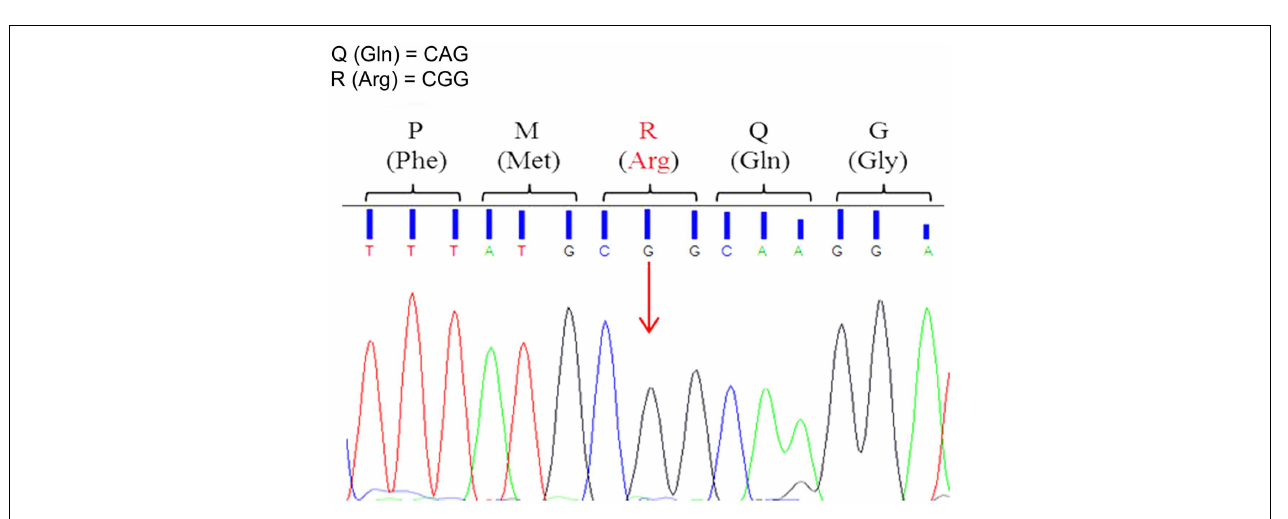
FIGURE 2 | Representative electropherogram of GluA2 Q/R editing-site sequence analysis . All animals, 3xTg-AD andWT, showed full editing with the Adenine to Guanine (A > G) substitution in the GluA2 Q/R editing site (arrow) indicated by the presence of a black peak (G) and the absence of a green peak